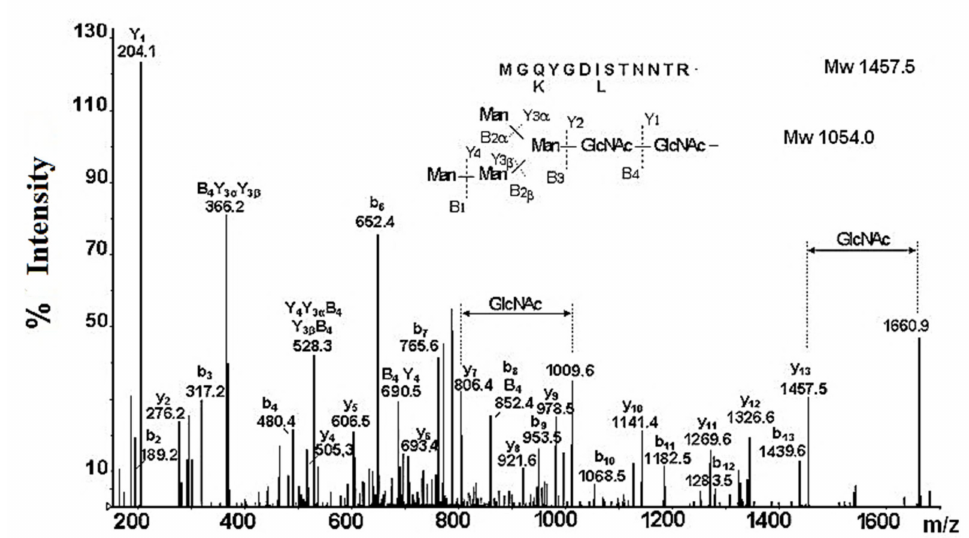
Figure 6. Enhanced product ion (EPI)—scanning of an ion with m / z 837.97 [M + 3H] 3 + with a higher